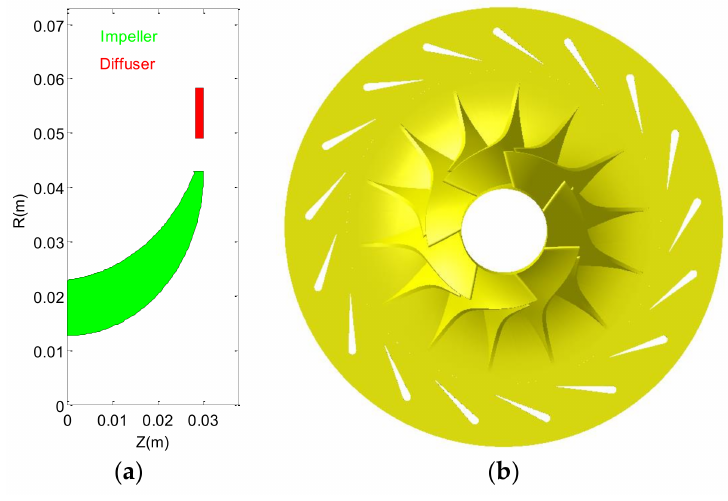
Figure 14. Centrifugal compressor (1 MWe). ( a ) Meridional plane; ( b ) 3D geometry.